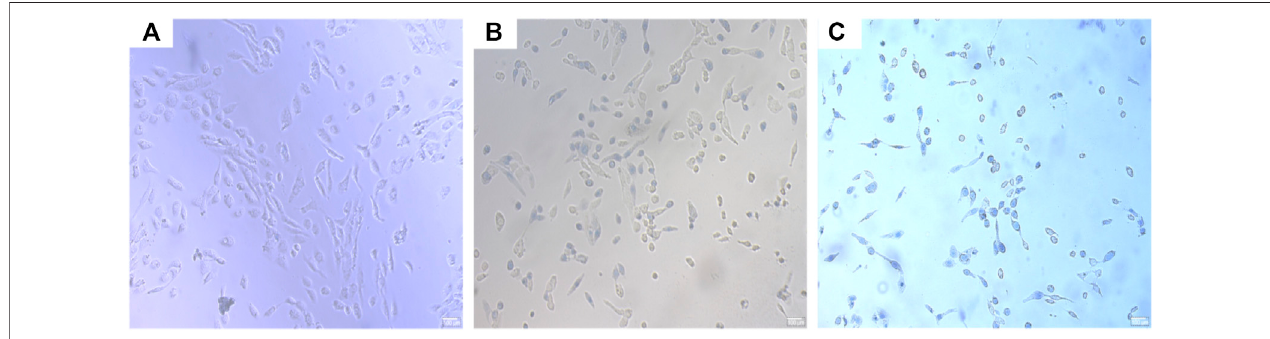
FIGURE 8 | OSCC trypan blue staining. (A) CMC microsphere group, (B) ICT-CMC microsphere group, and (C) ICT-CMC-CD59sp microsphere group.